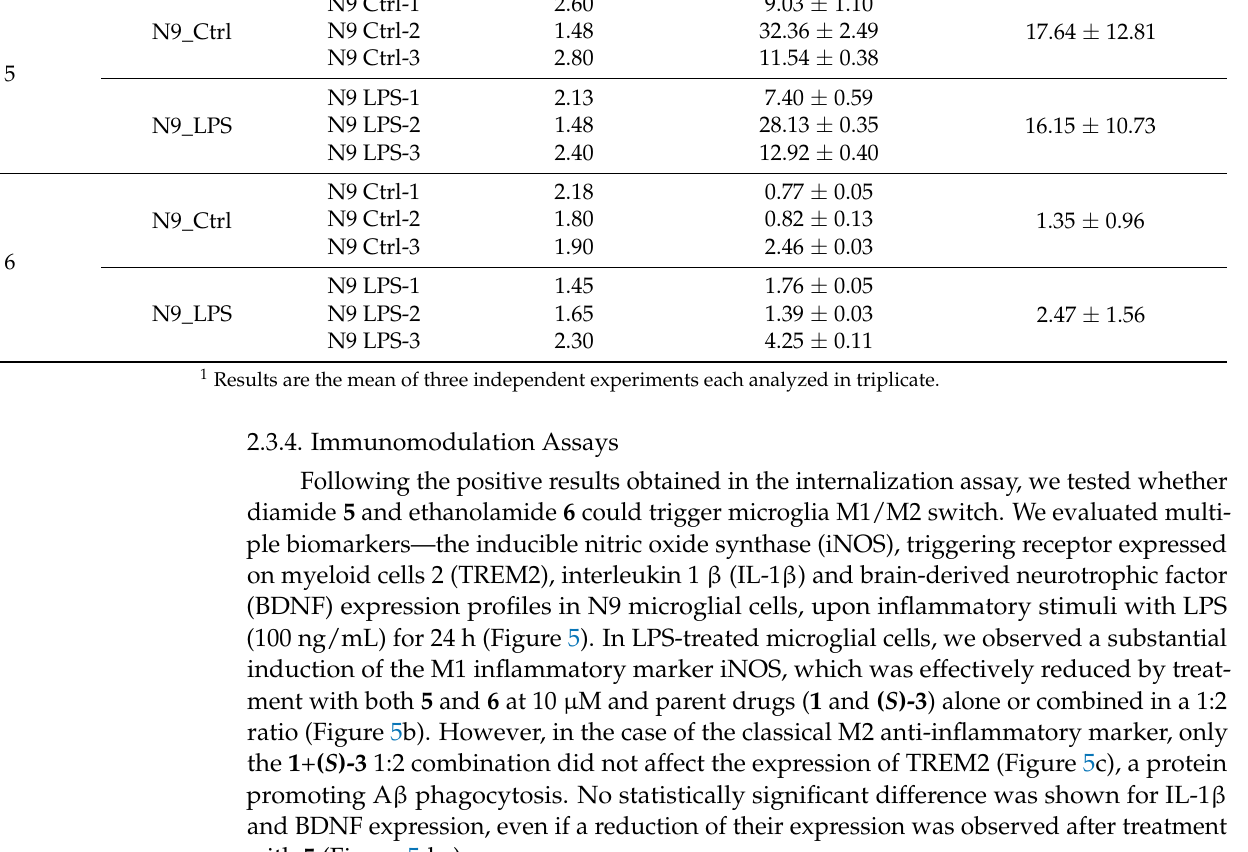
Table 1. Percentage of internalization of conjugates 5 and 6 in N9 microglial cells.